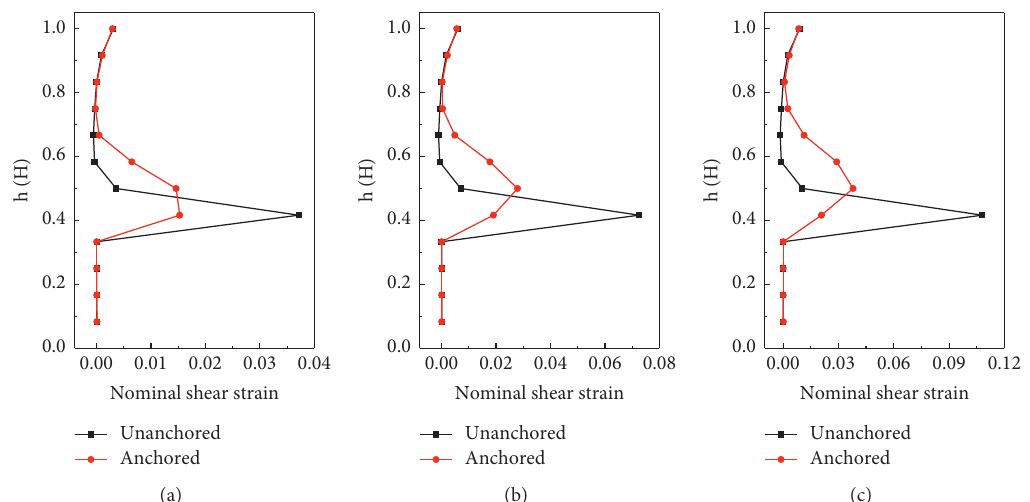
Figure 12: Nominal shear strain distribution along the elevation of the slope surface at different durations: (a) duration is 6 s;(b) duration is 12s; (c) duration is 18s.